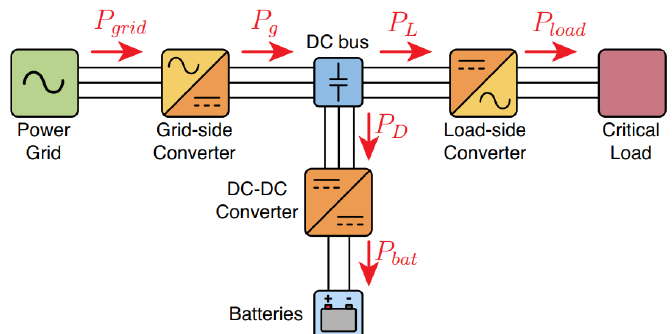
Figure 5. Power flow in a single UPS